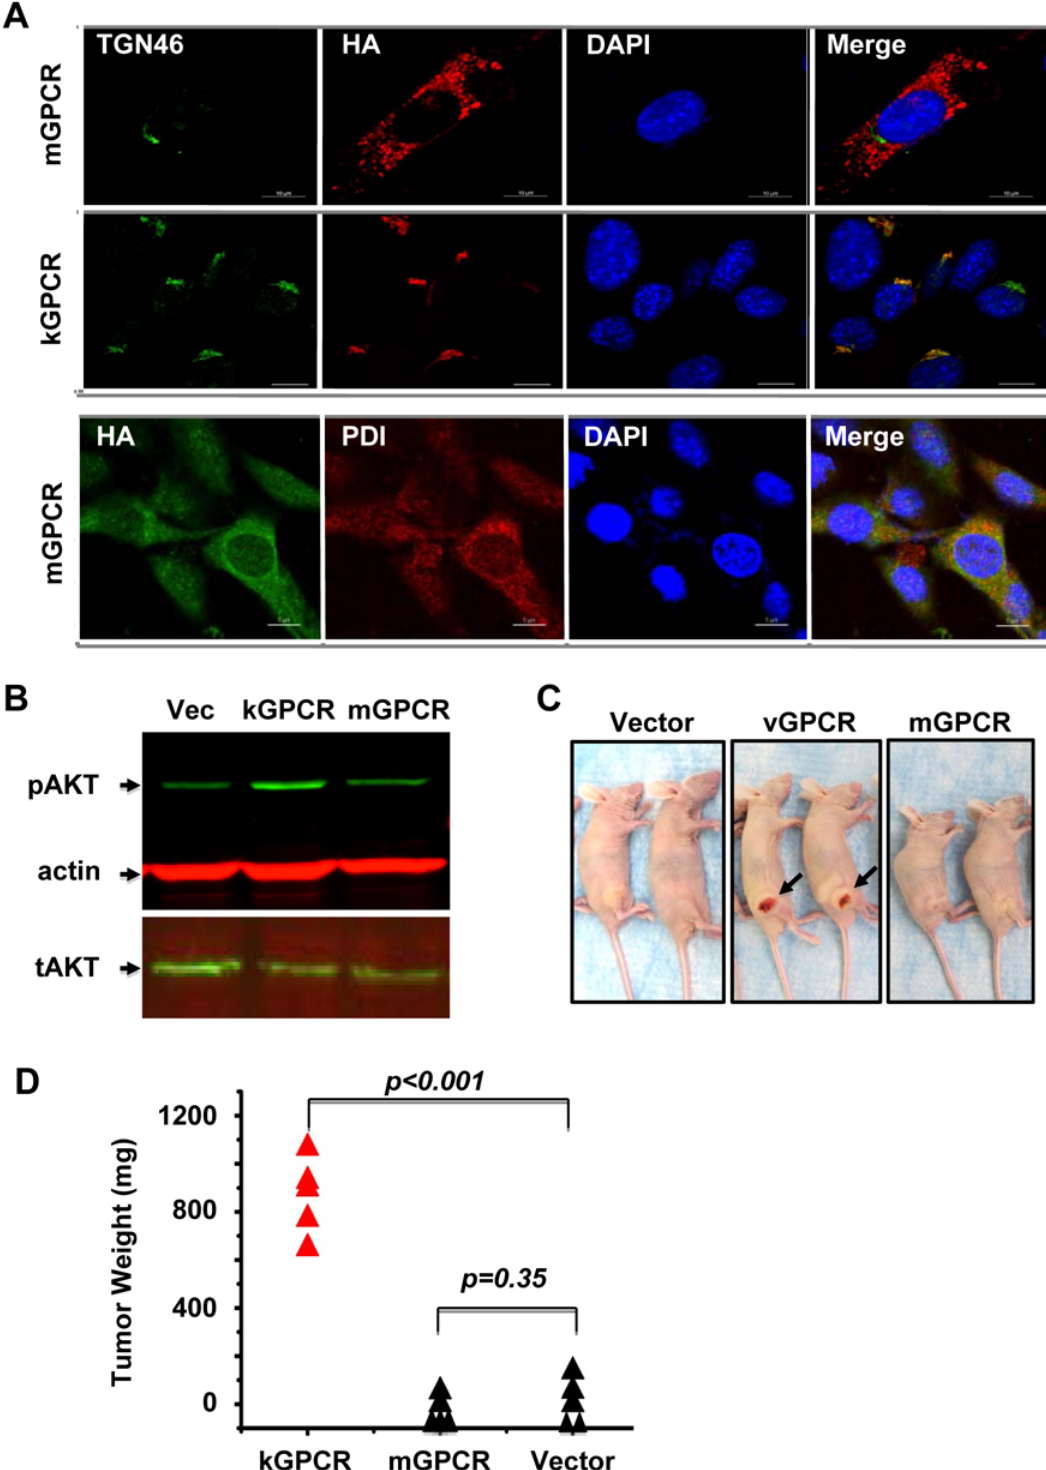
Fig 2. Differential signaling and tumorigenic capacity of kGPCR and mGPCR. (A) Mouse SVEC endothelial cells stably expressing kGPCR or mGPCR were fixed and stained with antibodies against the HA epitope (kGPCR or mGPCR), TGN46 (Golgi marker) or PDI (ER marker) and nuclei were stained with DAPI. Representative images were collected with Nikon and processed with ImageJ. Scale bar denotes 10 μ m. (B) Control SVEC or SVEC stable cells expressing kGPCR or mGPCR were starved overnight and whole cell lysates were analyzed with indicated antibodies. pAKT and tAKT indicate